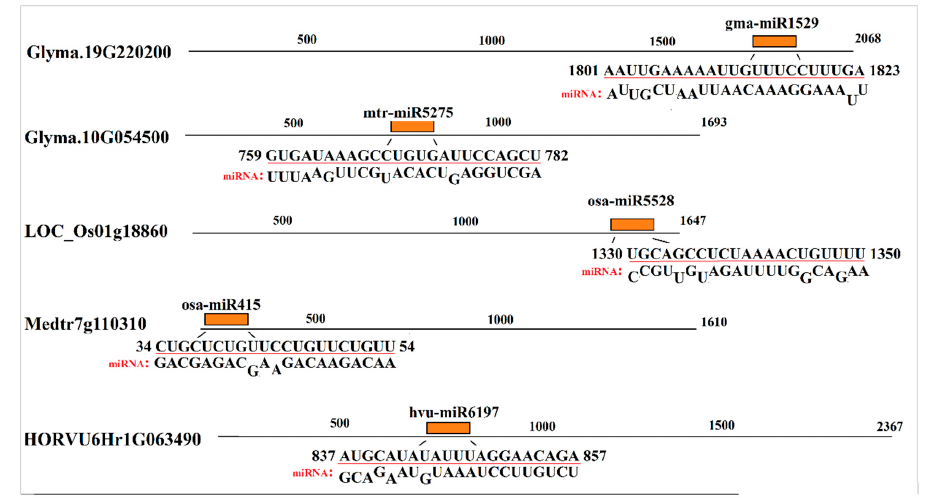
Figure 6. Predicted sites of microRNA targets in transcript sequences of the studied SAMS genes identified using the psRNATarget server. identified using the psRNATarget server. Plants 2020 , 9 , x FOR PEER REVIEW